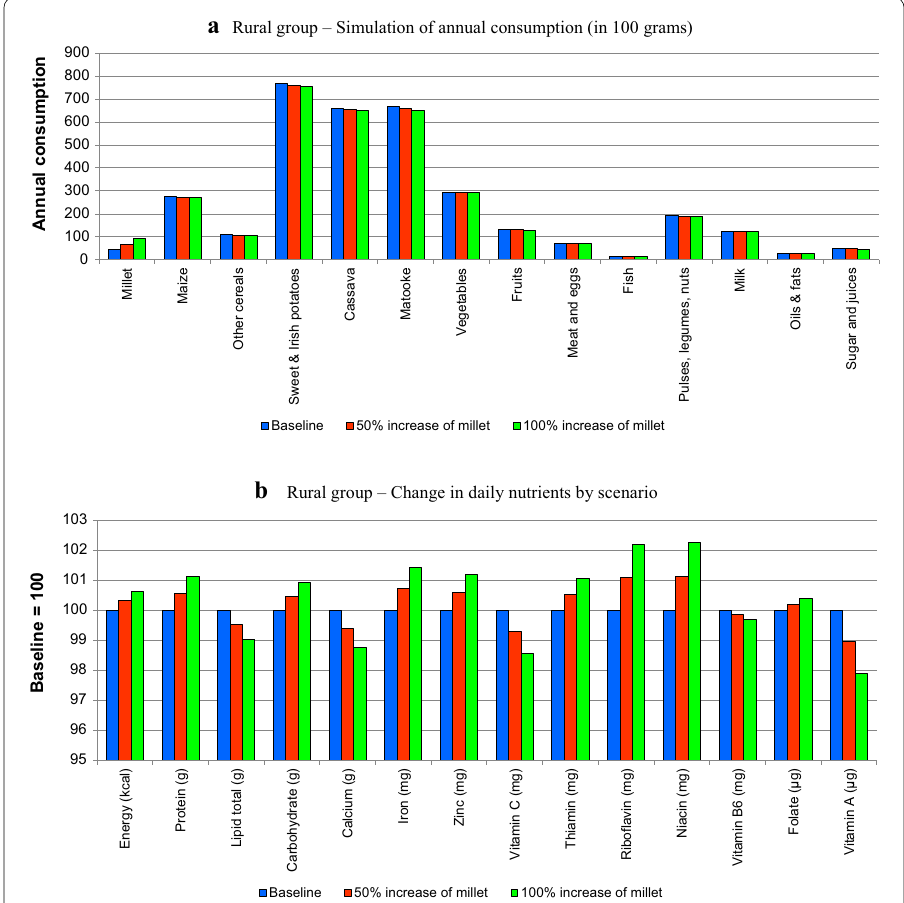
Fig. 3 a Rural group—simulation of annual consumption (in 100 g). b Rural group—change in daily nutrients by